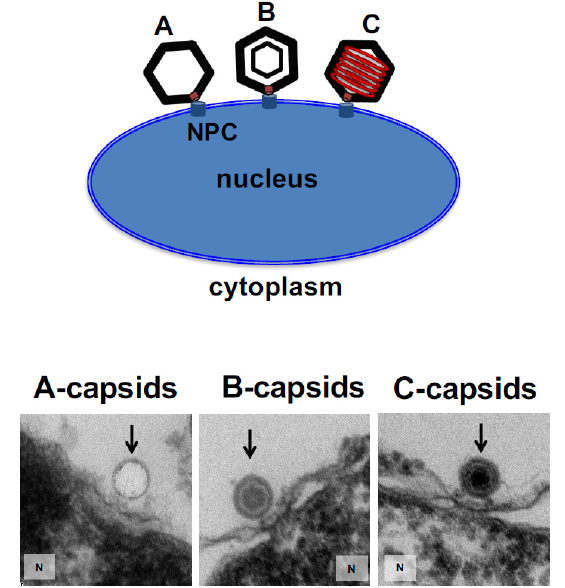
Figure 2. Ultra-thin sectioning EM shows binding of A-, B-, and C-capsids to the NPC basket structure at the nuclear membrane of reconstituted cell-free nucleus. The observed density inside the C-capsids corresponds to packaged DNA before it is ejected into the nucleus since sample was kept at 4 °C prior to fixation while DNA ejection occurs at 37 °C [13].